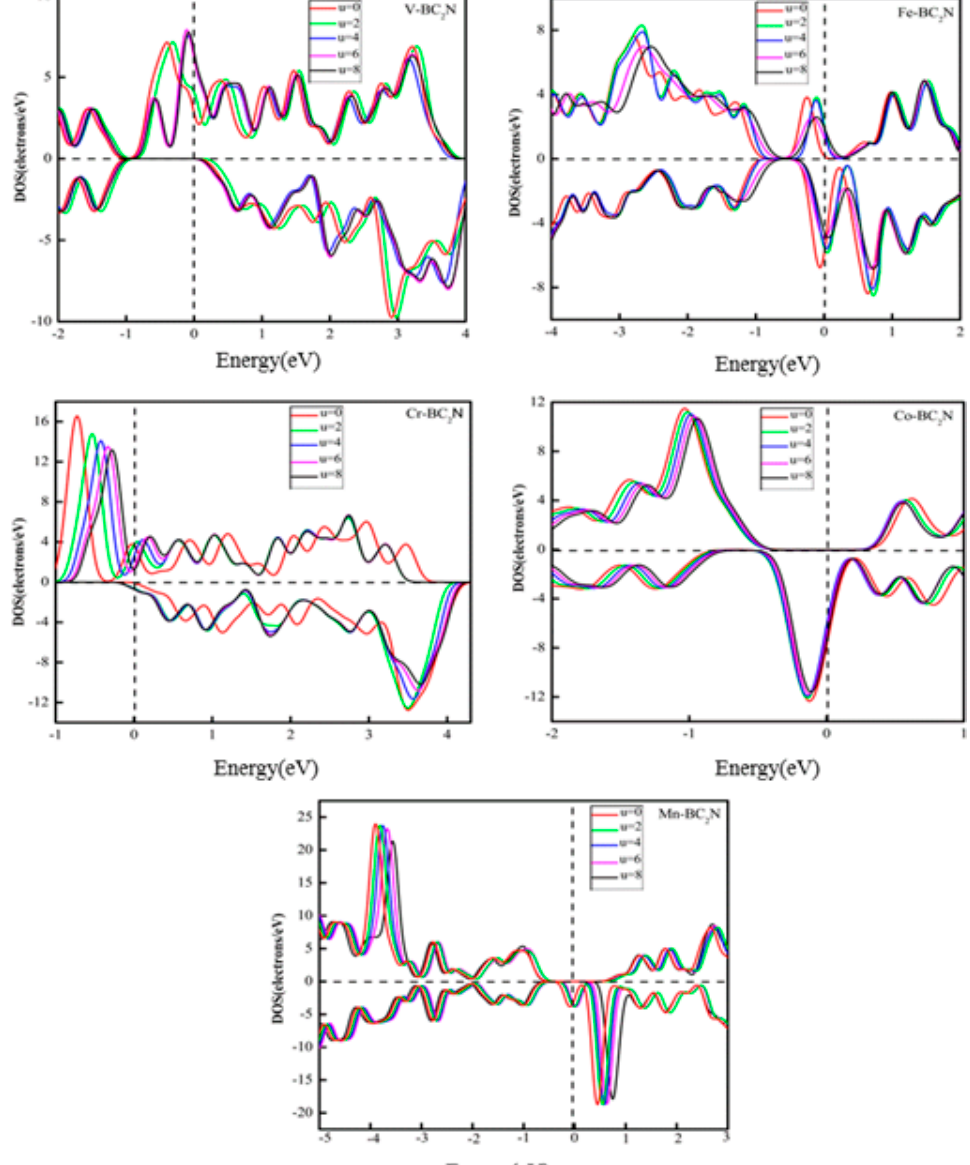
Figure 8. The total density of states of TM-BC 2 N (TM = V, Cr, Mn, Fe, Co, Ni) by generalized gradient approximation (GGA) and GGA + U with U = 0, 2, 4, 6, 8 eV for TM-3d electrons.